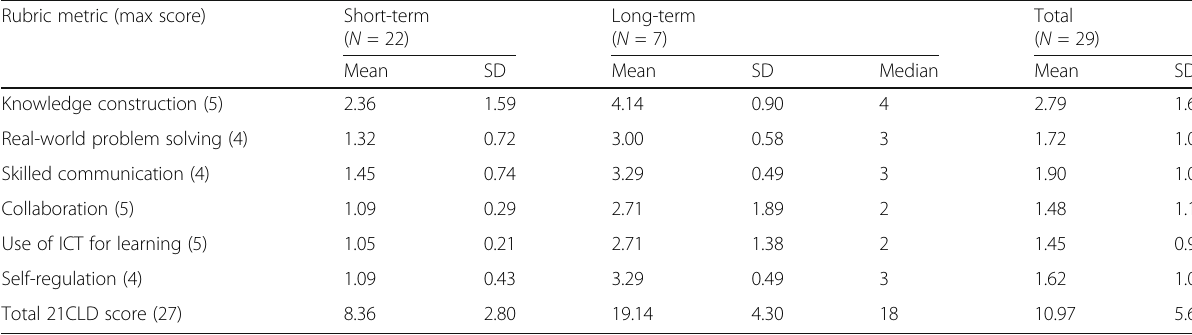
Table 6 Average rubric scores for student work samples Rubric metric (max score)